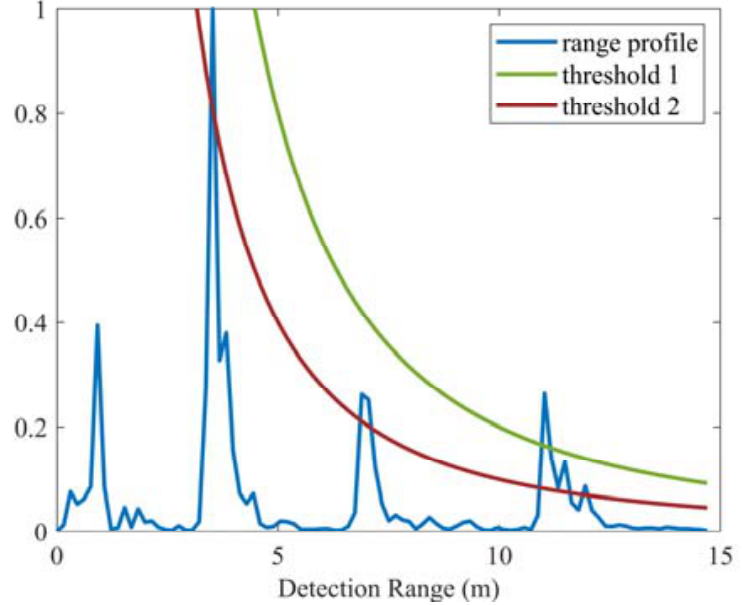
Figure 14. Comparison result processed by the method in [36] of the experiment with multiple tar ‐ gets.